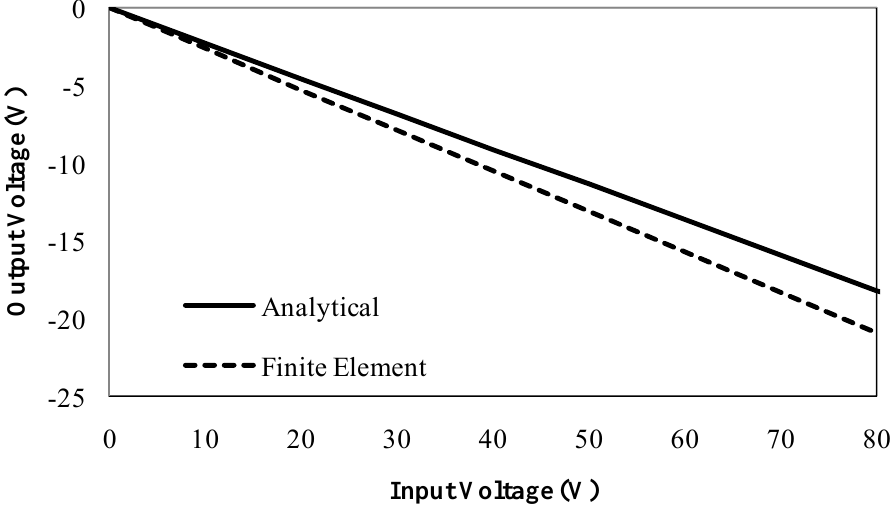
Figure 4. Comparison of induced voltage responses generated analytically and with finite element within the elastic